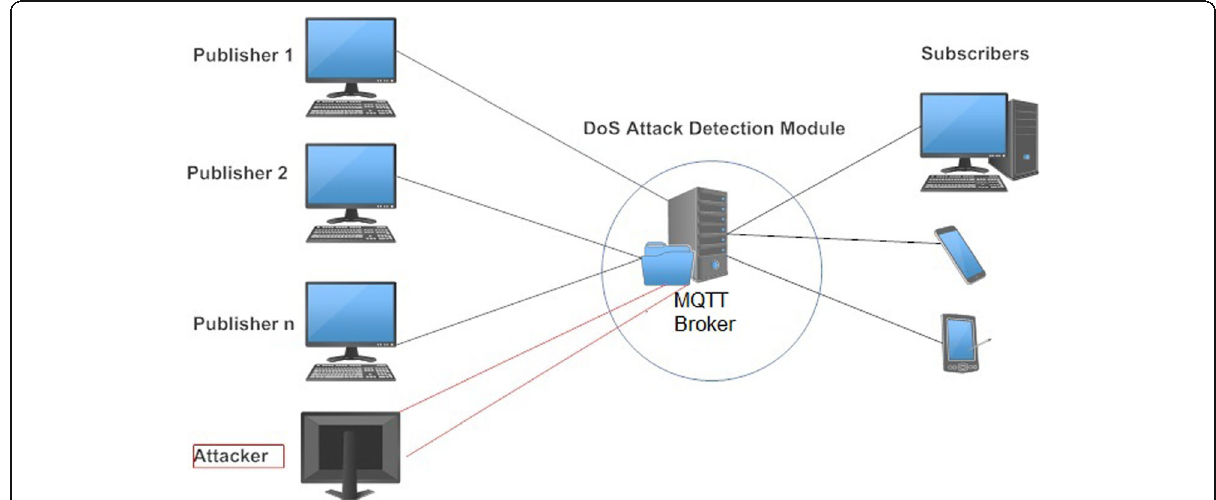
Fig. 2 Attack Scenario in the proposed